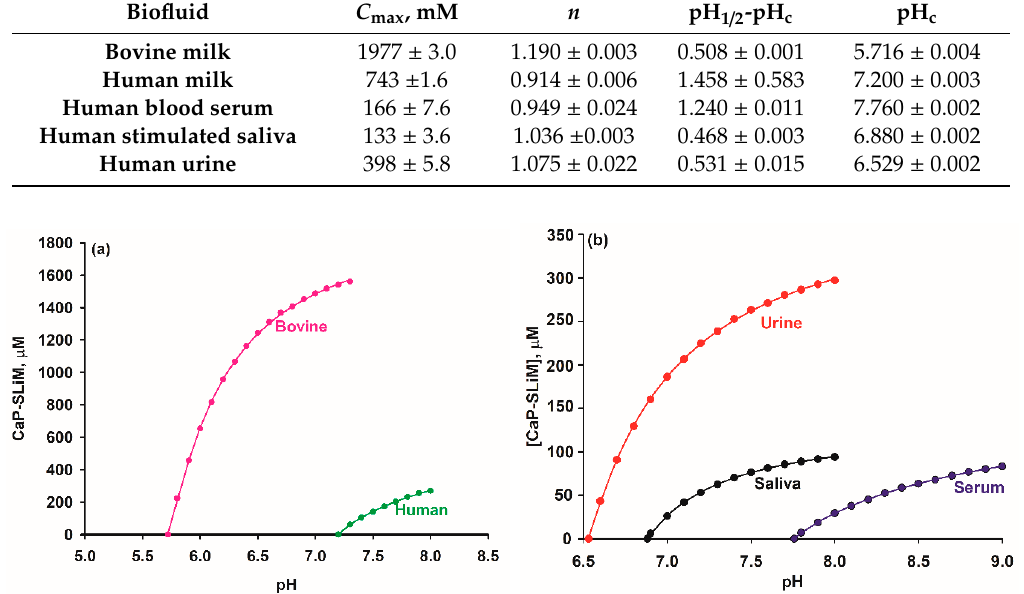
Table 4. Parameters of Equation (16) required to fit the stability curves of Figure 11. Biofluid